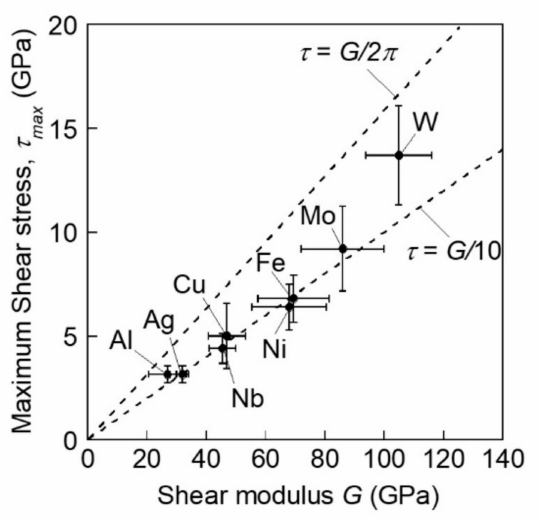
Figure 3. Relationship between the maximum shear stress, τ max , calculated from the pop-in load, P c , using Equation (3) and the stiffness modulus, G, converted from the Young’s modulus calculated from the unloading curve